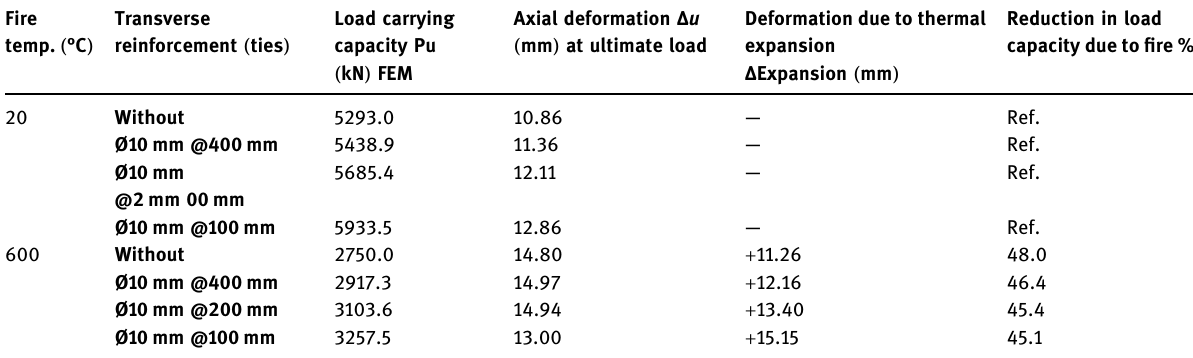
Table 4: The numerical results of analysis of RC column with di ff erent spacings of ties